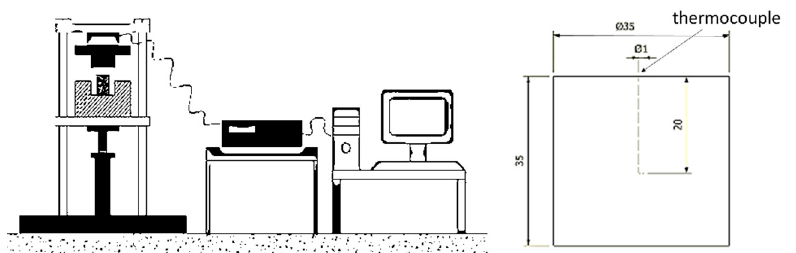
Figure 4. Schematic of the experimental arrangement for thixoforming a machined slug .